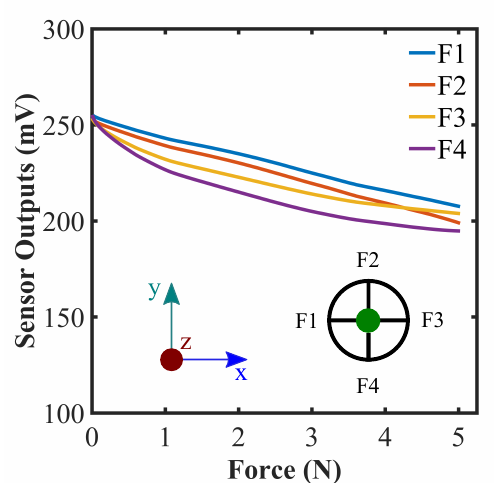
Figure 4. Force calibration against the normal force on the top of the hemispherical sensor; top view of the sensor system is shown, where four flex sensors are numbered as F1, F2, F3, and F4 accordingly. The green dot represents the force direction along z-axis into the